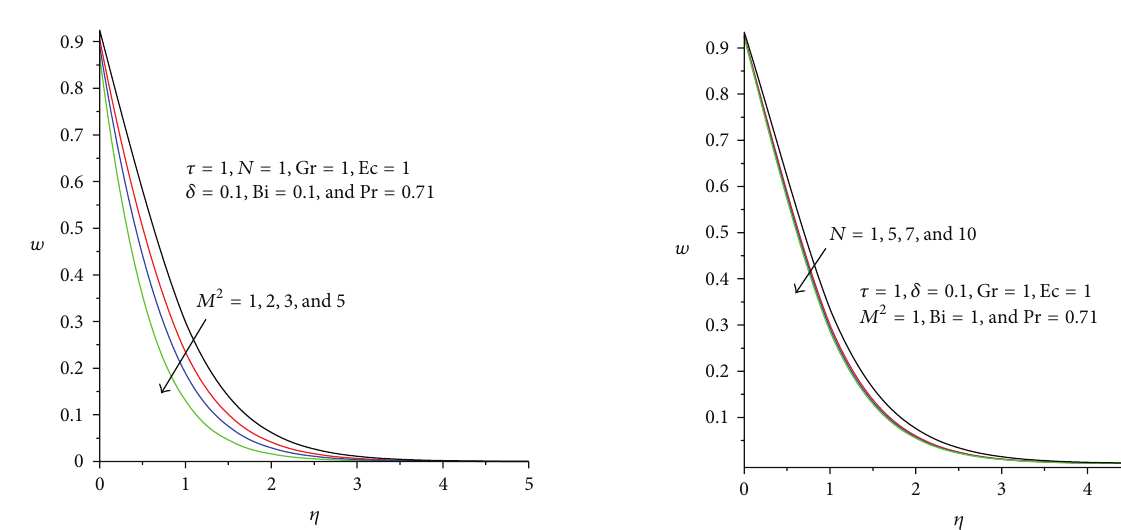
Figure 9: Velocity profiles with increasing 𝑁 .